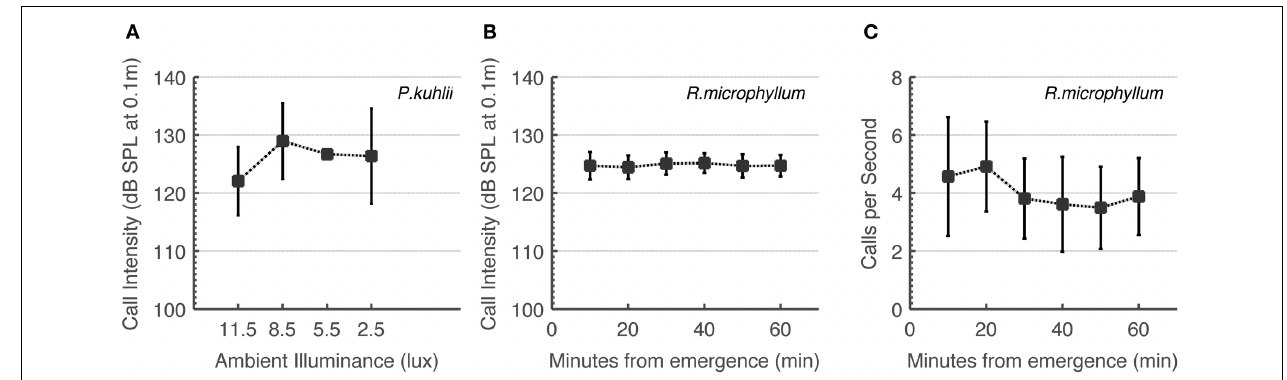
FIGURE 2 | R. microphyllum and P. kuhlii use echolocation under intermediate light levels to the same extent as in the dark. (A) P. kuhlii call intensity as a function of ambient light levels. (B) R. microphyllum call intensity as a function of time after sunset.